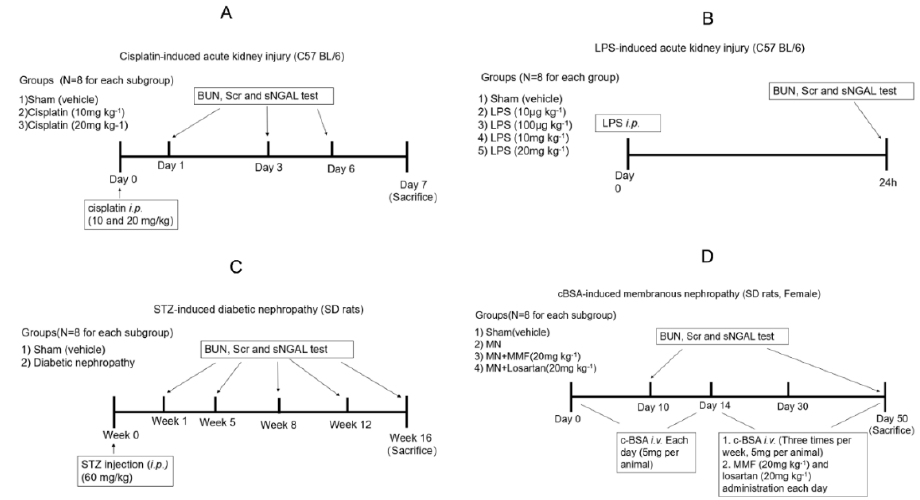
Figure 1. Experimental scheme of four acute kidney injury (AKI) and chronic KI (CKI) animal models. ( A ) Cisplatin-induced AKI; ( B ) LPS-induced AKI; ( C ) STZ-induced diabetic nephropathy; ( D ) c-BSA induced membranous nephropathy.